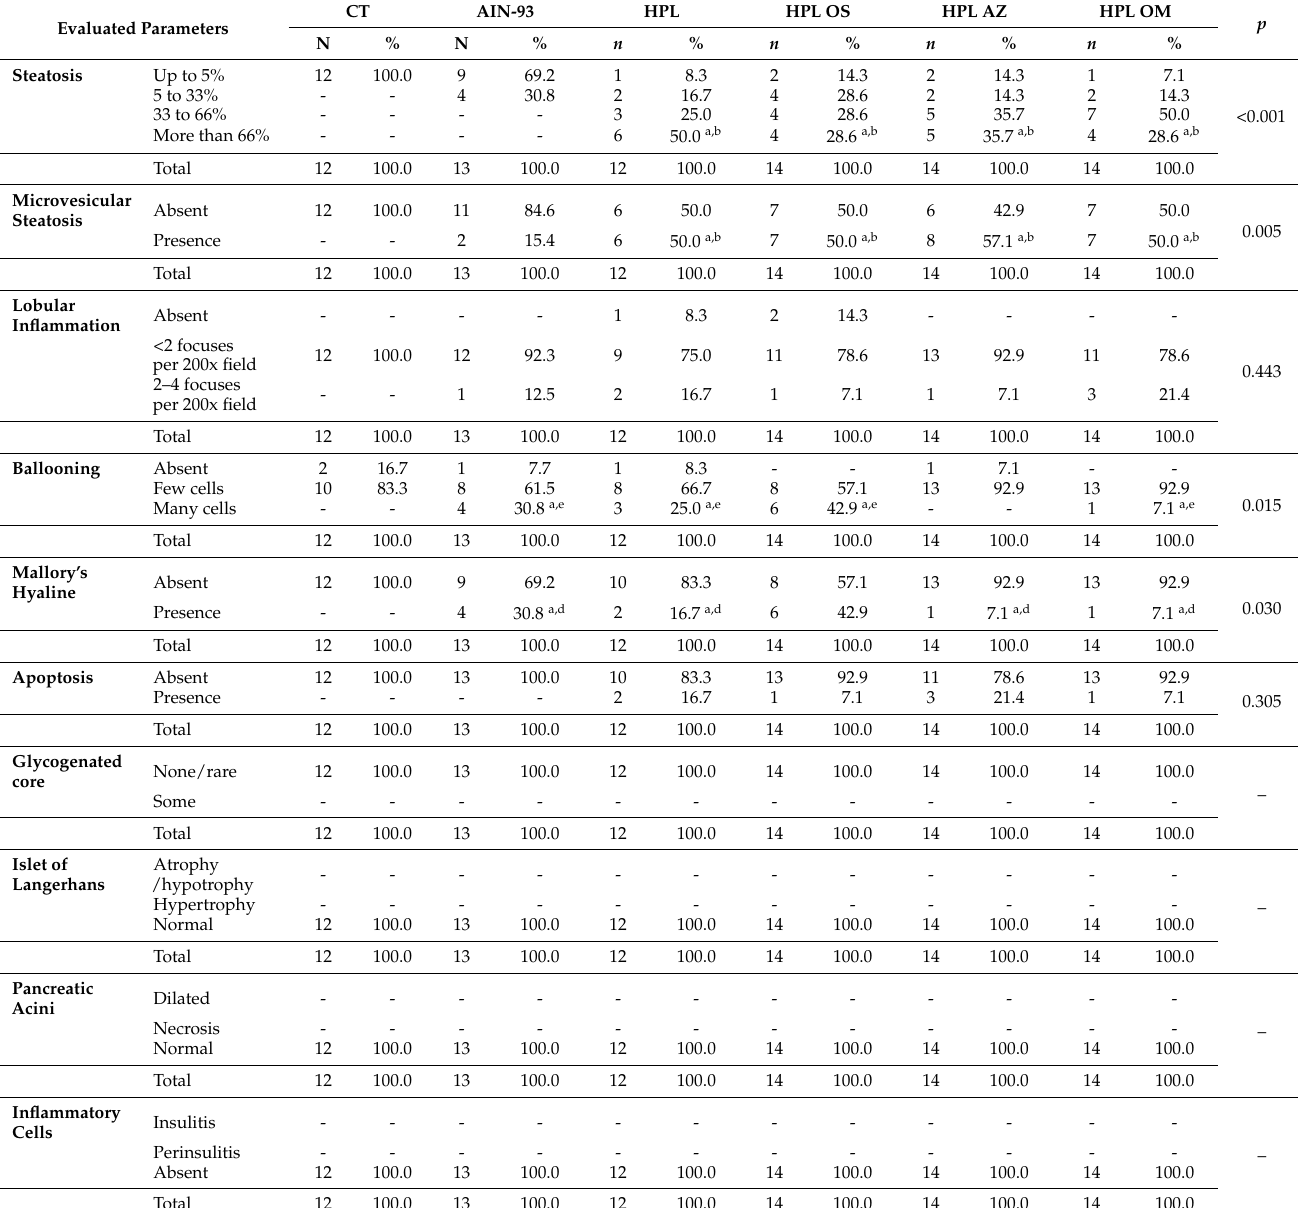
Table 4. Histological evaluation of the livers and pancreas of animals fed a balanced or high-fat diet and supplemented with saline, soybean oil, olive oil, or seed oil of papaya ( Carica papaya